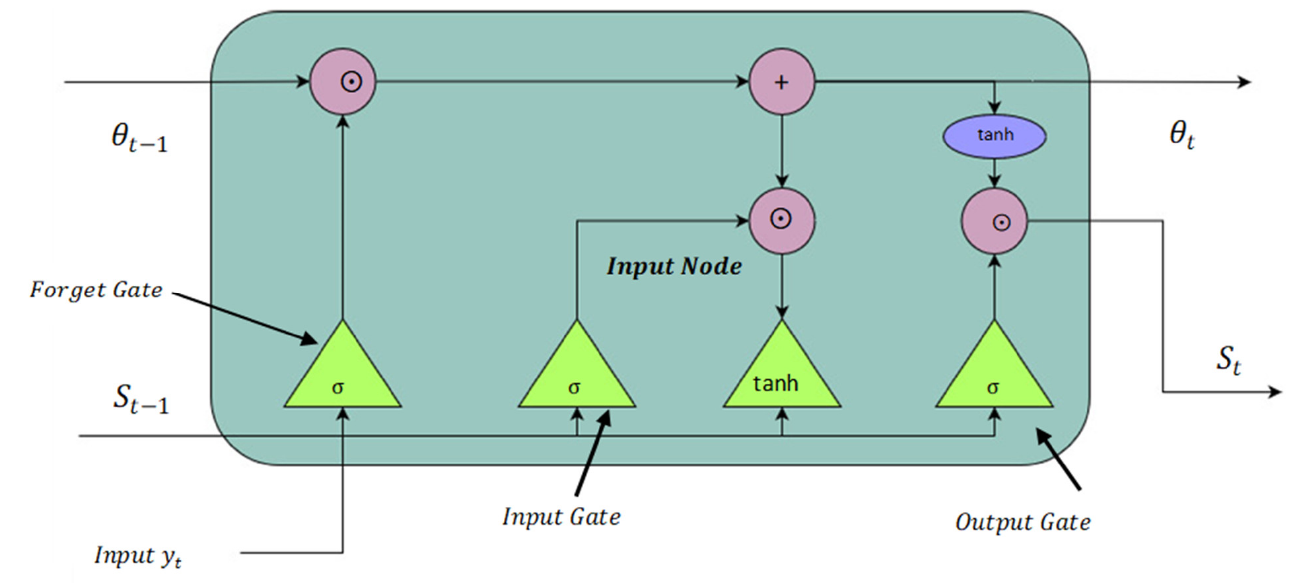
Figure 2. Stacked LSTM architecture.